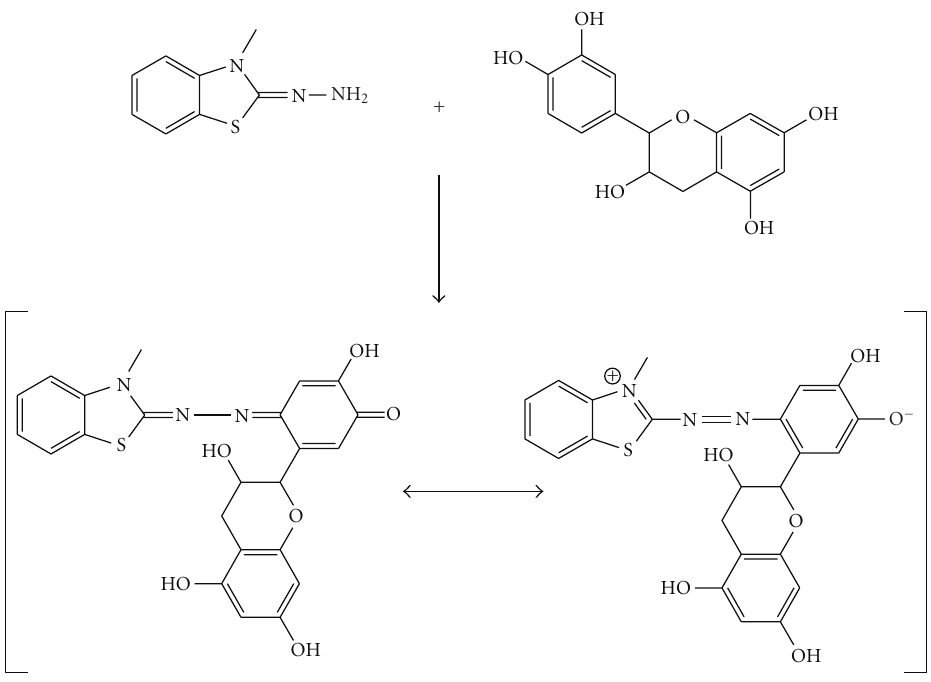
Scheme 1: Nucleophilic attach of the reagent MBTH to the